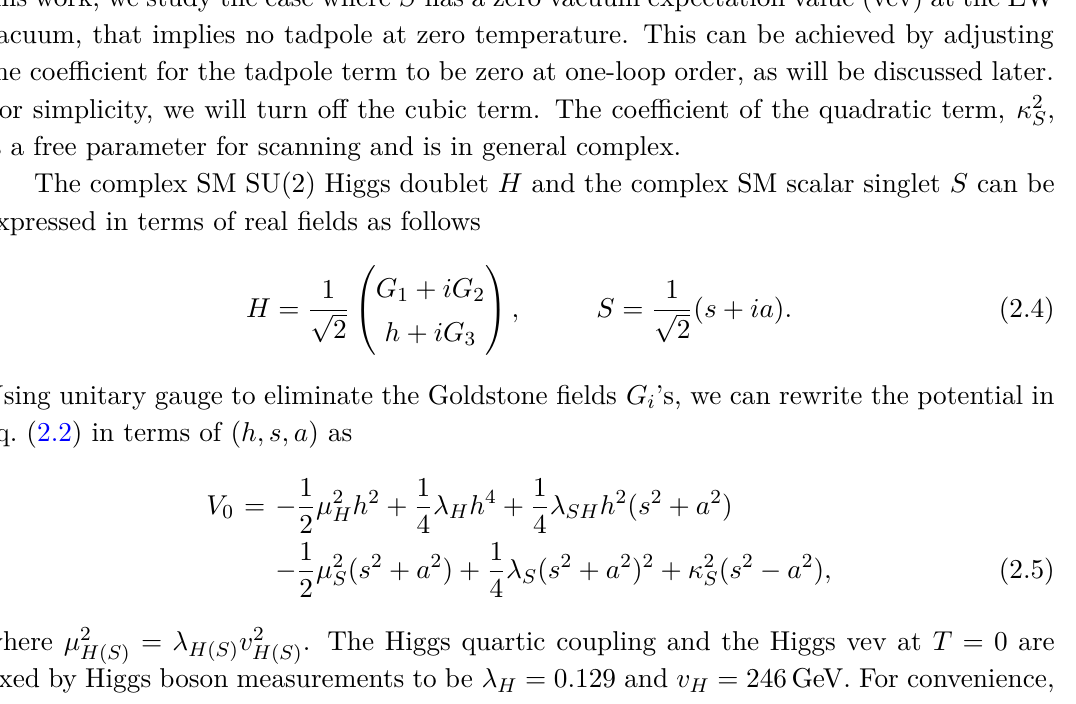
where H is the Higgs doublet